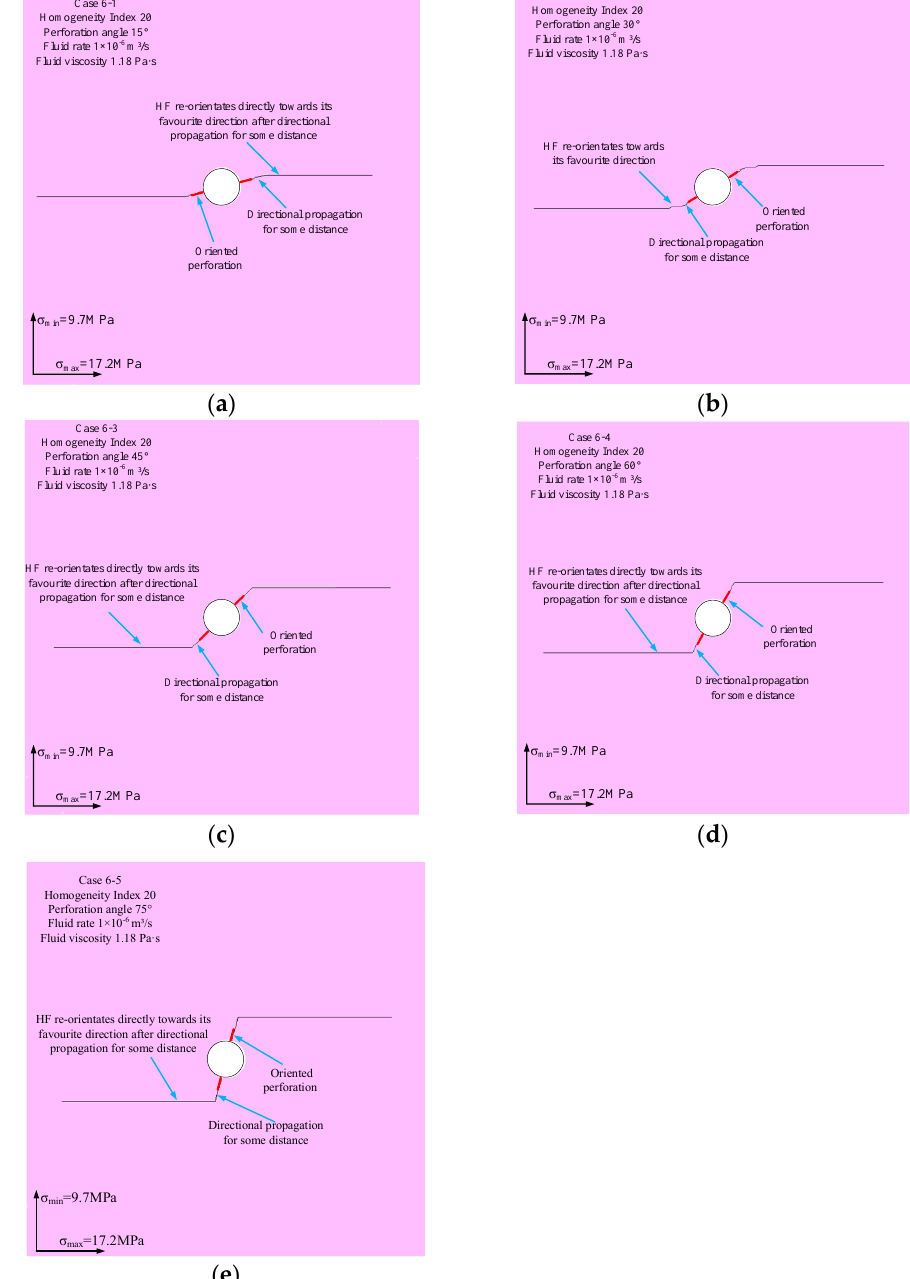
Figure 12. The relationship between HF re-orientation and perforation angle when the homogeneity index is 20: ( a ) perforation angle is 15°; ( b ) perforation angle is 30°; ( c ) perforation angle is 45°; ( d ) perforation angle is 60°; ( e ) perforation angle is 75°.